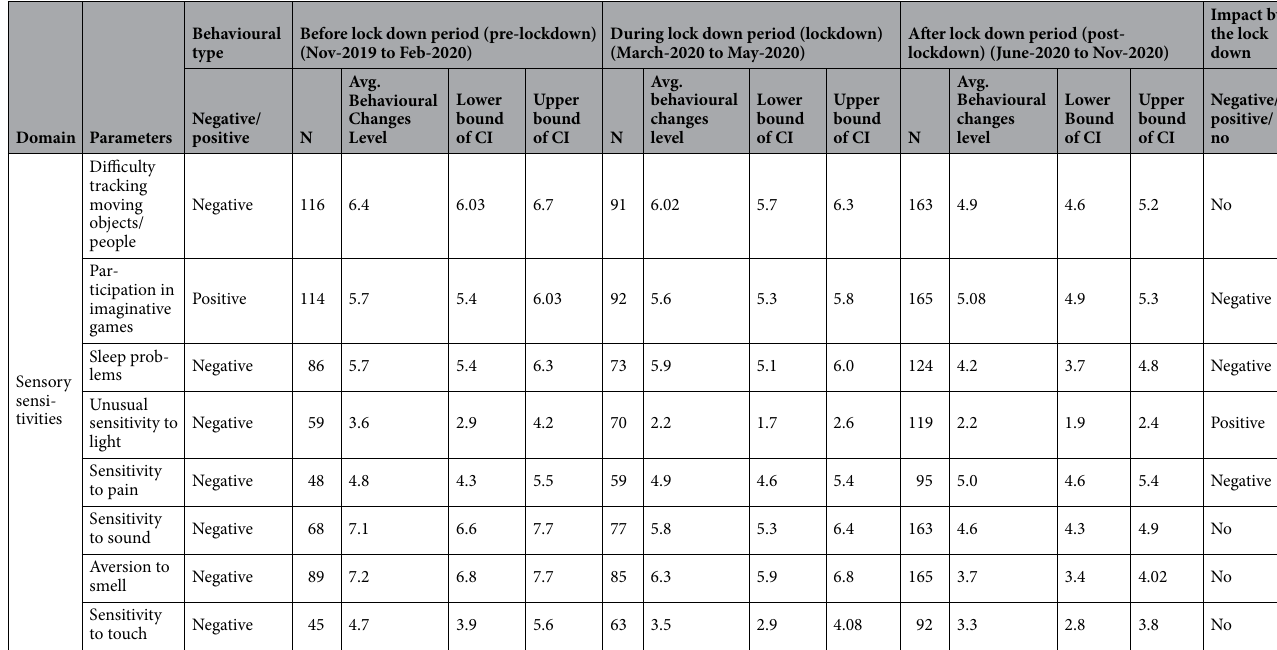
Table 3. Comparison behavioral changes of ASD children between the lockdown period and normal period (calculated by statistical mean with 95%